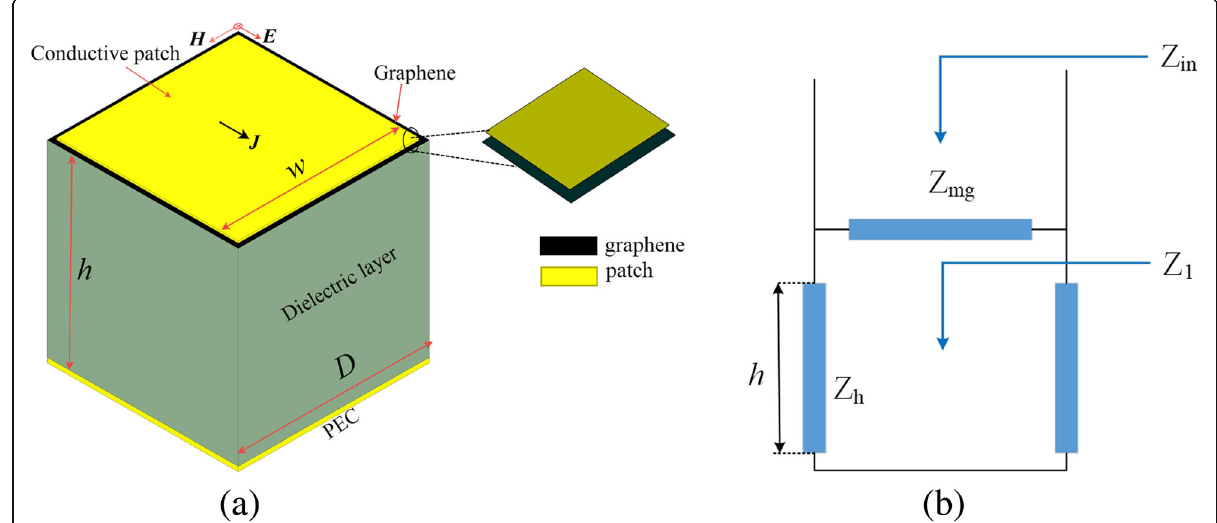
Fig. 1 a Schematic of the metasurface-graphene absorber unit cell. b Local equivalent circuit